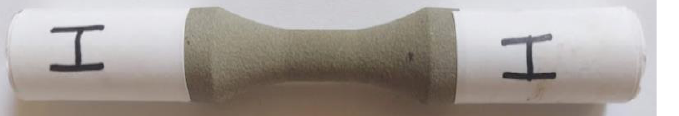
Figure 11. Macroscopic view of the surface of sample G (4340) after 5 million cycles.